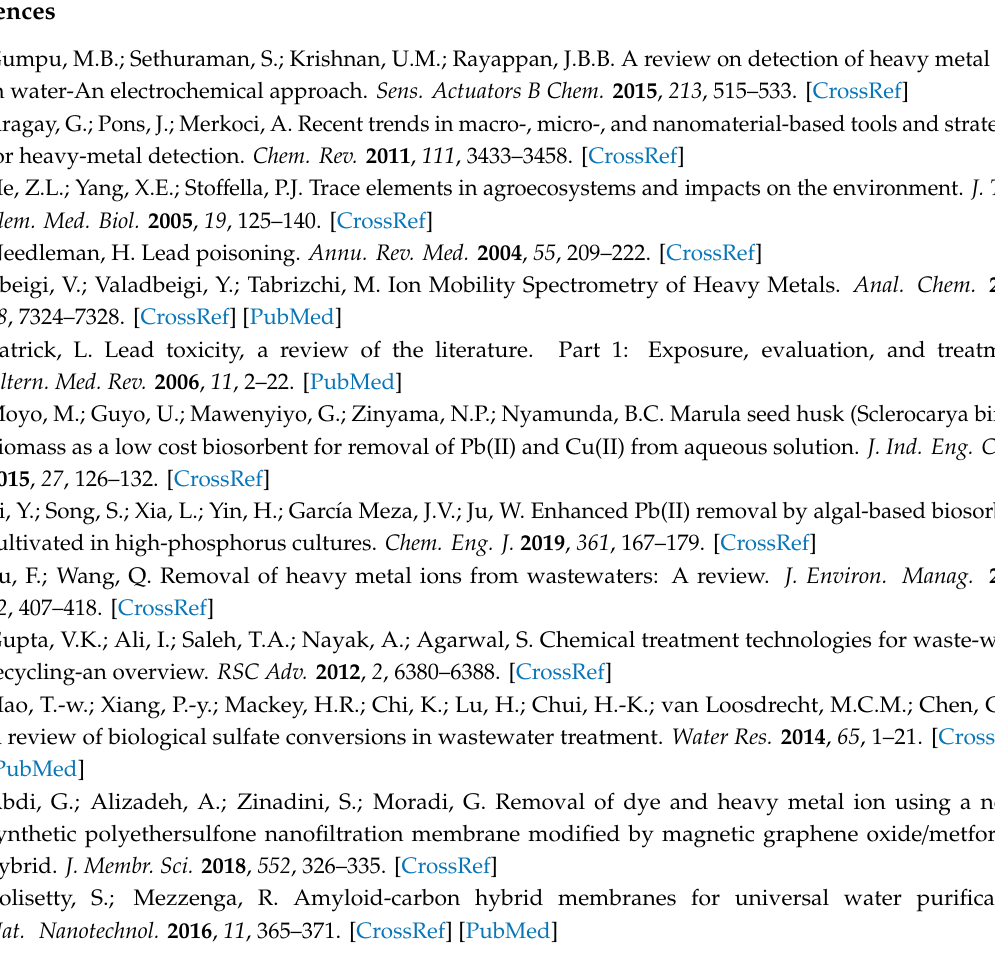
Figure S1: Photography of solution change at reaction times of 0 min and 10 min., Figure S2: Diameter distribution of products from 0 to 24 h, Figure S3: (a) The surface zeta potential measurement of SF@Cu-NFs at pH = 4.0–9.0; (b) Adsorption capacity of the prepared SF@Cu-NFs for Pb(II) at pH = 4.0–9.0, Figure S4: The adsorption isotherms of Pb(II) fitting by (a) Langmuir model, (b) Freundlich model and (c)Temkin model, Figure S5: Evaluation of SF@Cu-NFs adsorption selectivity for (i) Pb(II), (ii) Cd(II) and (iii) Ni(II). Insets are HMIs solution after di ff erent adsorption of 0, 5, 20, 40 and 90 min. The chromogenic reagent for Pb(II) and Cd(II) are DTZ and for Ni(II) is DMG, Figure S6: XRD spectra of SF@Cu-NFs before (spectrum i) and after (spectrum ii) Pb(II) adsorption, Table S1: The related EDS data of SF@Cu-NFs, Table S2: Comparison maximum capacity of SF@Cu-NFs products in this work and other adsorbents for Pb(II) adsorption., Table S3: Thermodynamic data for Pb(II) adsorption by SF@Cu-NFs at di ff erent